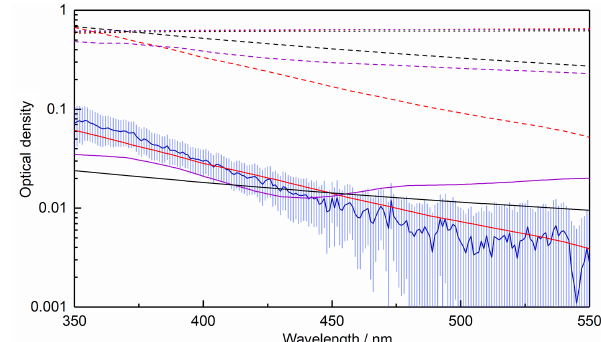
Figure 6. Measured OD as a function of wavelength (blue line), compared with the average OD calculated from literature data for haematite (red, Hsu and Matijevic, 1985; Longtin et al., 1988; Querry, 1985), magnetite (purple, Fontijn et al., 1997; Huffman and Stapp, 1973; Querry, 1985) and wüstite (black, Henning and Mutschke, 1997) using the measured size distribution (dotted lines), the RDG approximation with a monomer concentration derived from the measured size distribution (dashed lines) and the RDG approximation with a monomer concentration fitted to the experi- mental data (solid lines).